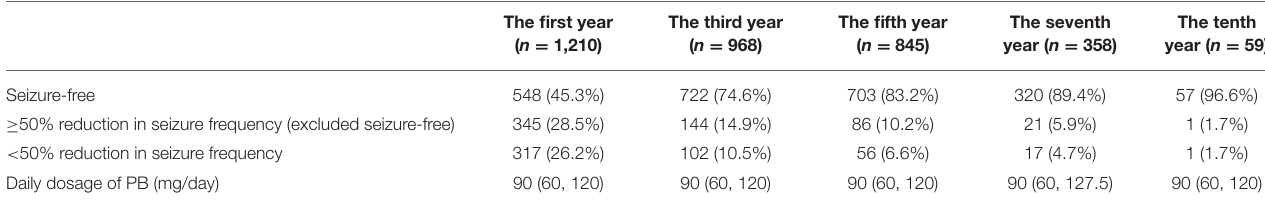
TABLE 2 | The changes in convulsive seizure frequency compared to baseline and the daily dosage of PB, N (%) or median (P25,